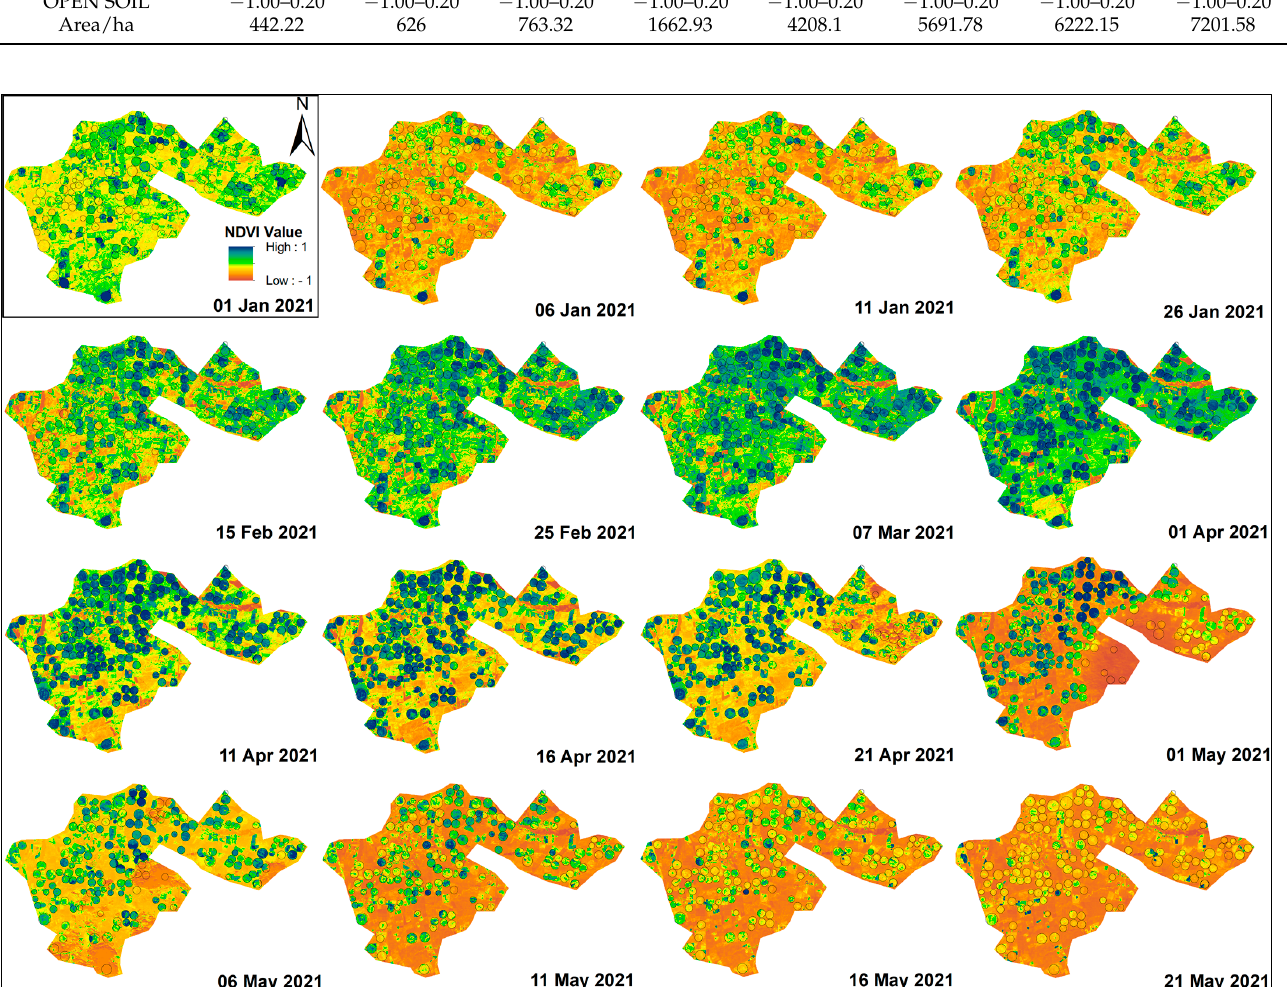
Figure 5. Temporal Variation of the NDVI Value-Based Vegetation Density Classes of Wheat Field in 2021.